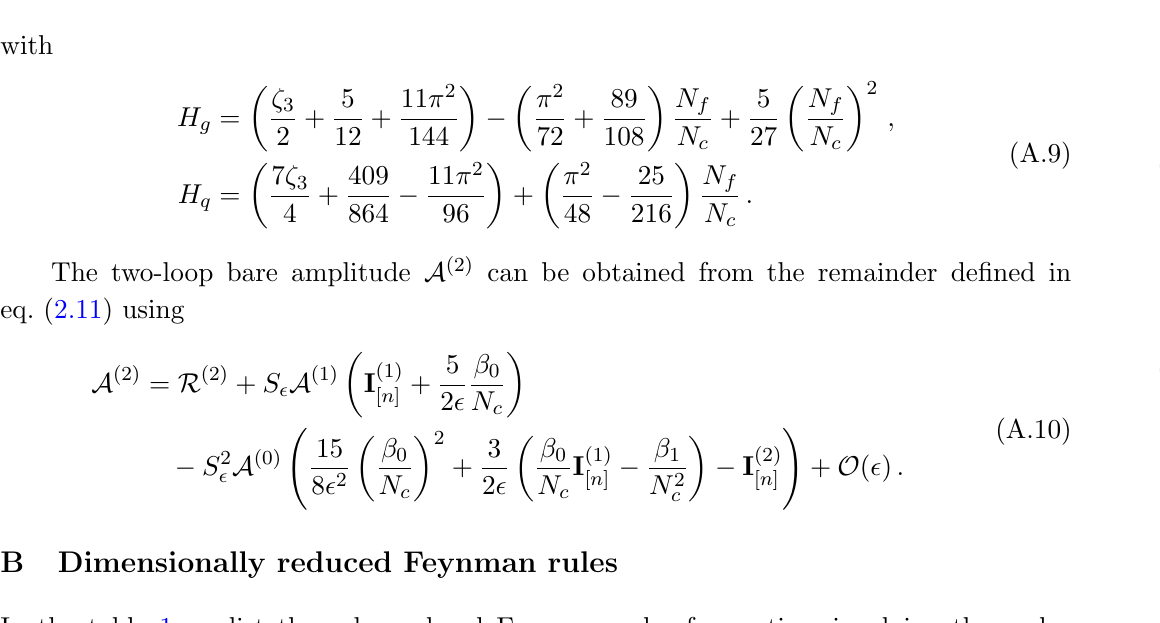
Table 1 . Color-ordered Feynman rules for vertices with scalar particles explicitly introduced by dimensional reduction of